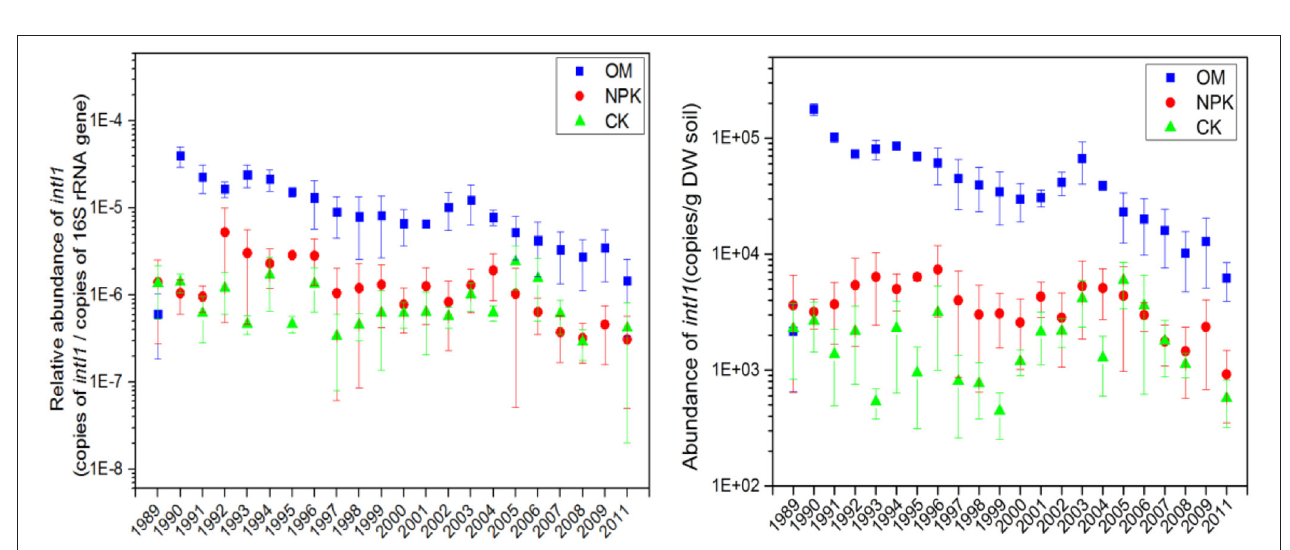
FIGURE 4 | The variation trend in the abundance of the intI1 gene in different fertilizer treated archived